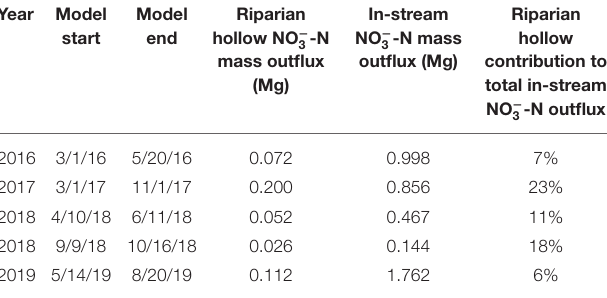
TABLE 3 | Scaled contribution of the total NO − 3 outflux from riparian hollows across the catchment to the in-stream NO − 3 -N outflux for each of the simulation